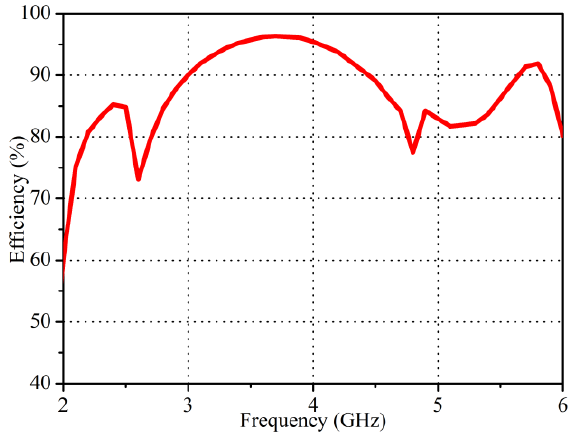
Figure 7: Effect of the design parameter S 0 on the reflection coefficients.